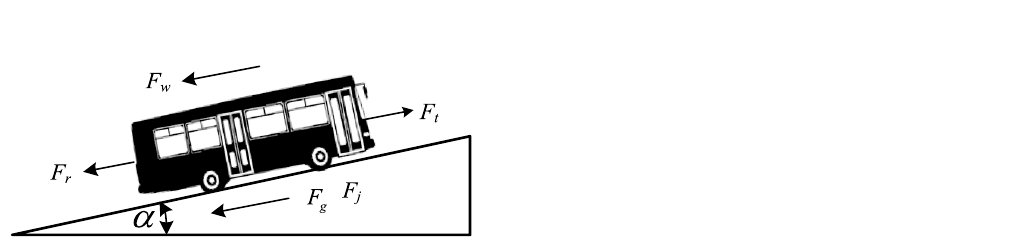
Table 1. Main parameters.